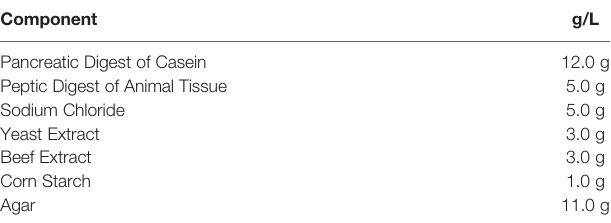
TABLE 12 | Columbia agar Criterion ™